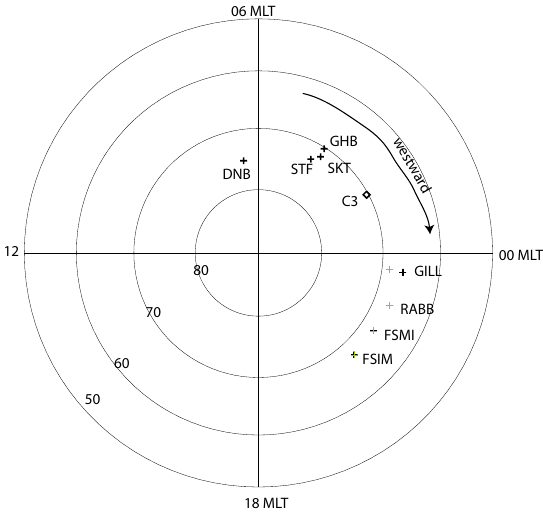
Fig. 13. The summary of 1.1-mHz wave observations in terms of the MLT-Mlat